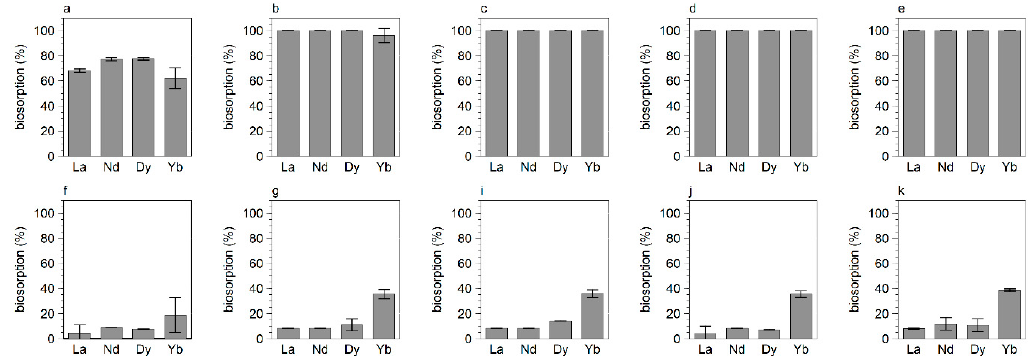
Figure 8. Comparison of REE biosorption by Fusarium sp. with living ( a – e ) and dead ( f – k ) biomass at different time intervals, ( a , f ): 0 h, ( b , g ): 2.5 h, ( c , i ): 5.5 h, ( d , j ): 8 h, ( e , k ): 25 h. Biomass was 5 g/L, pH was 2.5.